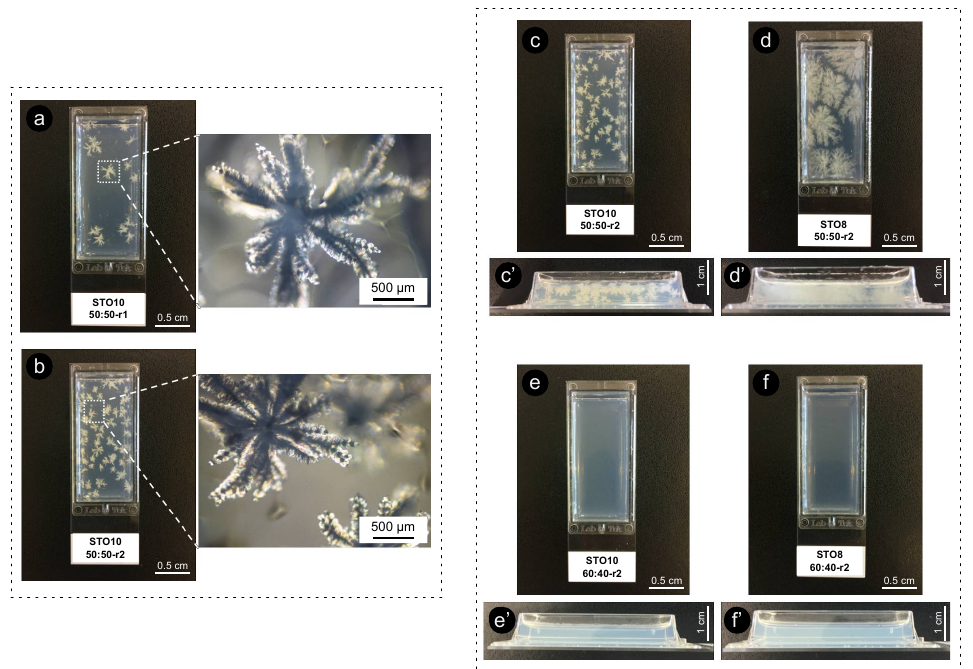
Figure 6. Images of oleogels obtained under different cooling ramps after 2 weeks of storage (r1 = 1 °C·min −1 and r2 = 7 °C·min −1 ). On the left are also images obtained by polarized microscopy. ( a ) STO10 50:50-r1, ( b ) STO10 50:50-r2, ( c ) STO10 50:50-r2, ( d ) STO8 50:50-r2, ( e ) STO10 60:40-r2, ( f ) STO8 60:40-r2. ( c’ ), ( d’ ), ( e’ ), and ( f’ ) show the respective cross-section view.